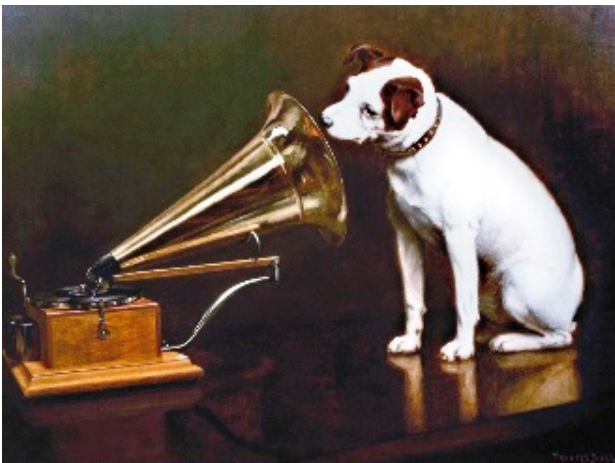
Figure 15. “ His Master’s Voice” Francis Barraud, 1898. Public Domain, via Wikimedia Commons.